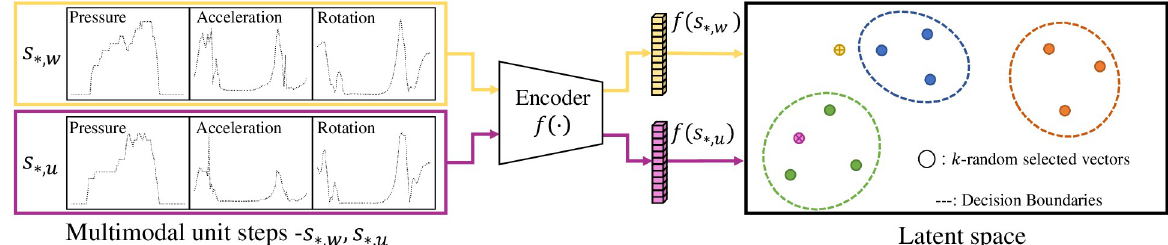
is recognized as that of the “green” subject, whereas unit step u